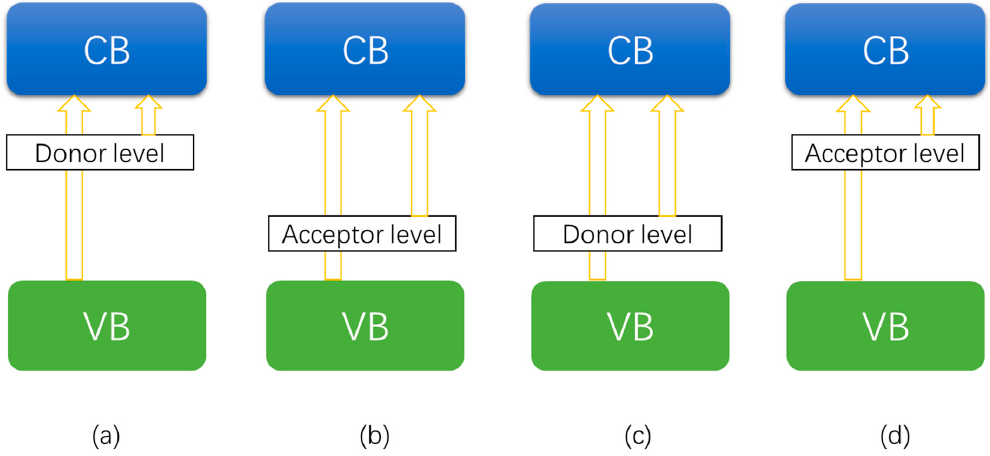
Figure 3. Effects of metal doping on band structure of semiconductors: ( a ) shallow donor level, ( b ) shallow acceptor level, ( c ) deep donor level, and ( d ) deep acceptor level formed by metal doping.